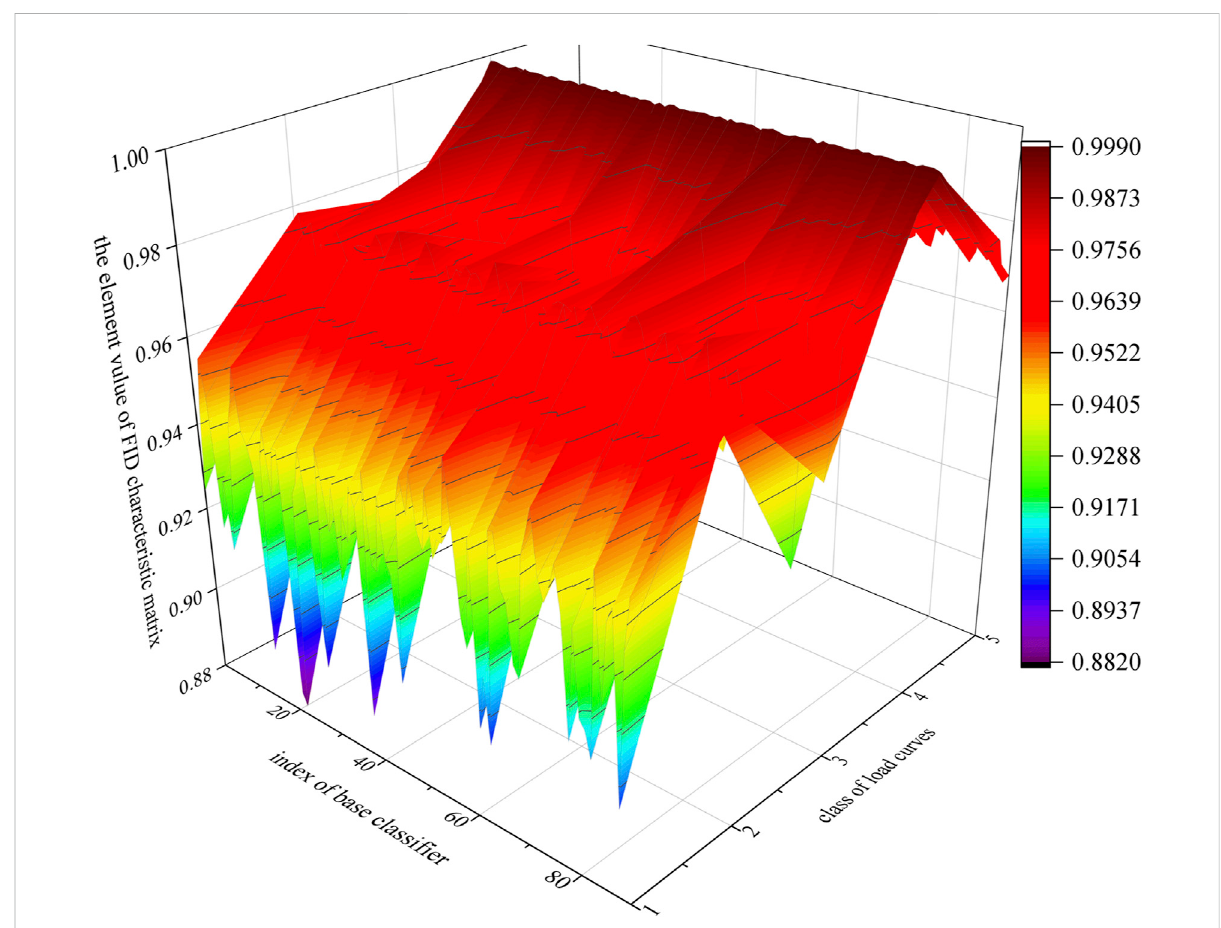
FIGURE 5 The FID characteristic matrix of 100 BPNN base classi fi